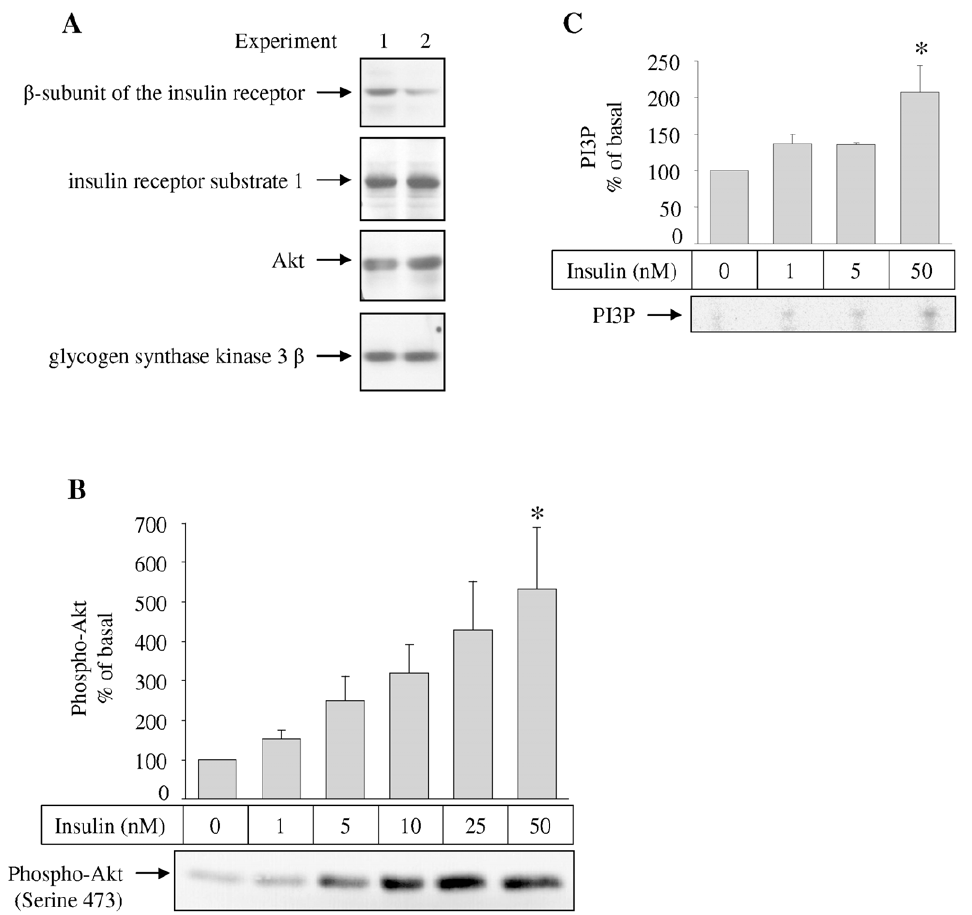
Figure 3. Protein expression, insulin-stimulated Akt phosphorlyation, and insulin-stimulated phosphatidylinositiol 3 9 -phosphor- ylation in human astrocytes. ( A ) Equal amounts of total cell lysates of two independent experiments were loaded onto a SDS-PAGE gel. The indicated proteins were detected using specific antibodies. ( B ) Cells were stimulated with the indicated insulin concentrations for 15 minutes and lysed afterwards. Akt phosphorylation was detected by a phospho-specific antibody. A representative western blot is shown in the lower part. Bars in the diagram represent means + SEM. N=6. There were significant differences between the groups (ANOVA, p=0.0108). * indicates significant difference from 0 nM insulin (Tukey Kramer post hoc test p , 0.05). ( C ) Following insulin stimulation with insulin for 30 minutes, cells were harvested, and lysates were immunoprecipitated with anti IRS-1 antibodies and a PI-3 kinase assay was performed using L- a -phosphatidylinositol as substrate. A representative image is shown in the lower part. Bars in the diagram represent means + SEM. N=3. There were significant differences between the groups (ANOVA, p=0.0267). * indicates significant difference from 0 nM insulin (Tukey Kramer post hoc test p , 0.05).